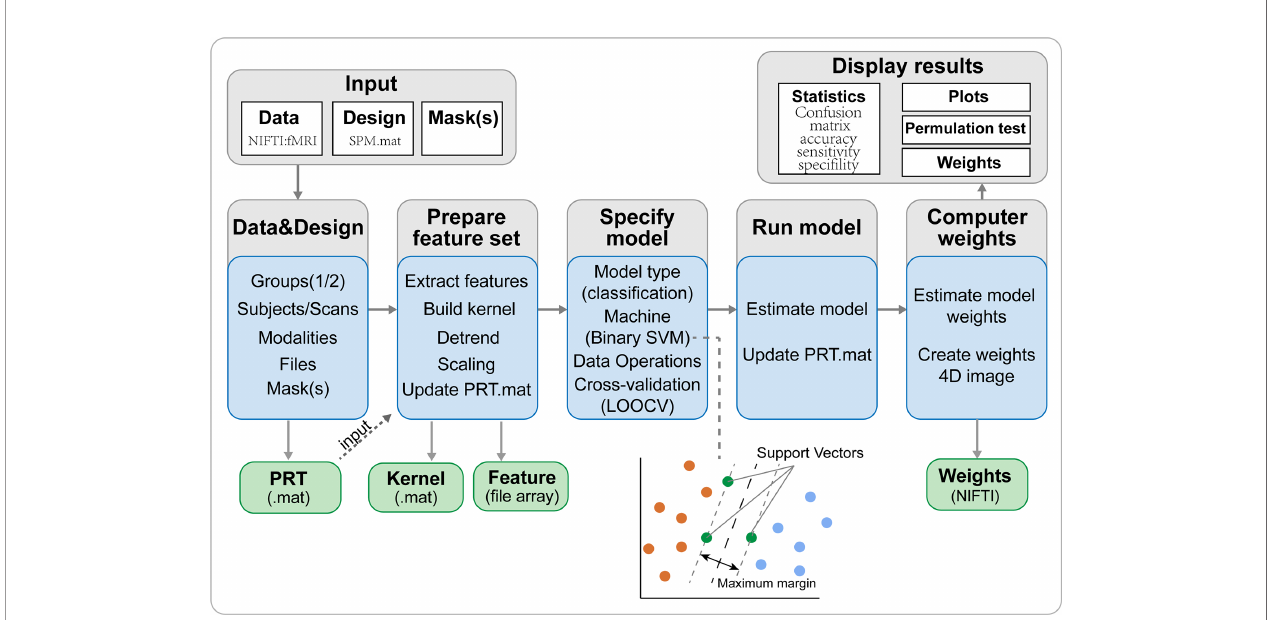
FIGURE 5 | The framework of PRoNTo. The PRoNTo software has fi ve main analysis modules: (i) dataset speci fi cation; (ii) feature set selection; (iii) model speci fi cation; (iv) model estimation; (v) weights computation. The PRT.mat is the output data structure from PRoNTo. SVM, support vector machine; LOOCV, SVM, support vector machine.